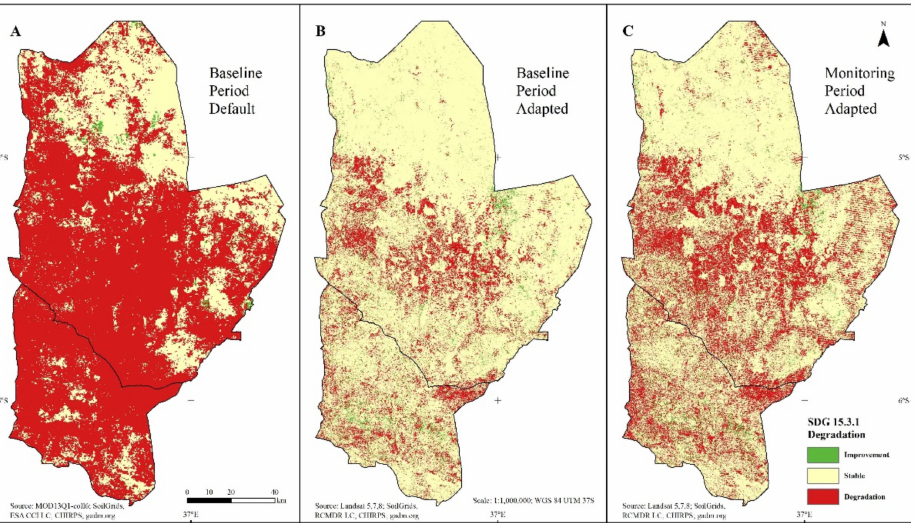
Figure 7. The sustainable development goal (SDG) 15.3.1 indicator “proportion of land that is degraded over total land area” for the baseline period with the ( A ) default and ( B ) adapted methods, and ( C ) for the first monitoring period using the adapted